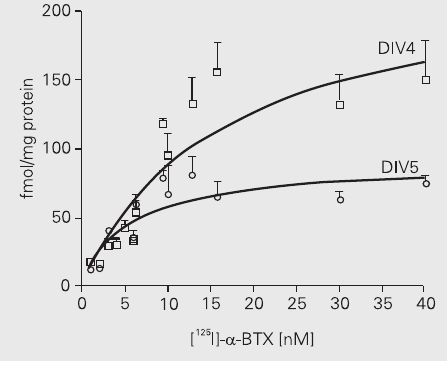
Figure 6. Pretreatment with luzindole (panels A and B - 100 µM; panel C - 0.1 to 100 µM) for 48 h inhibited the α -bungaro- toxin-sensitive component of acetylcholine (ACh)-induced in- creases in extracellular acidifica- tion rate by retinal cultured cells. The effects on 4-day (DIV4) and 5-day (DIV5) in vitro cultures are shown in panels A and B , re- spectively. Open and filled sym- bols represent the effect in the absence and presence of 10 nM α -bungarotoxin, respective- ly. Squares and circles indicate the effect in cultures pretreated with 100 µM luzindole and un- treated controls, respectively. Panel C shows a concentration- response curve for DIV5 cul-